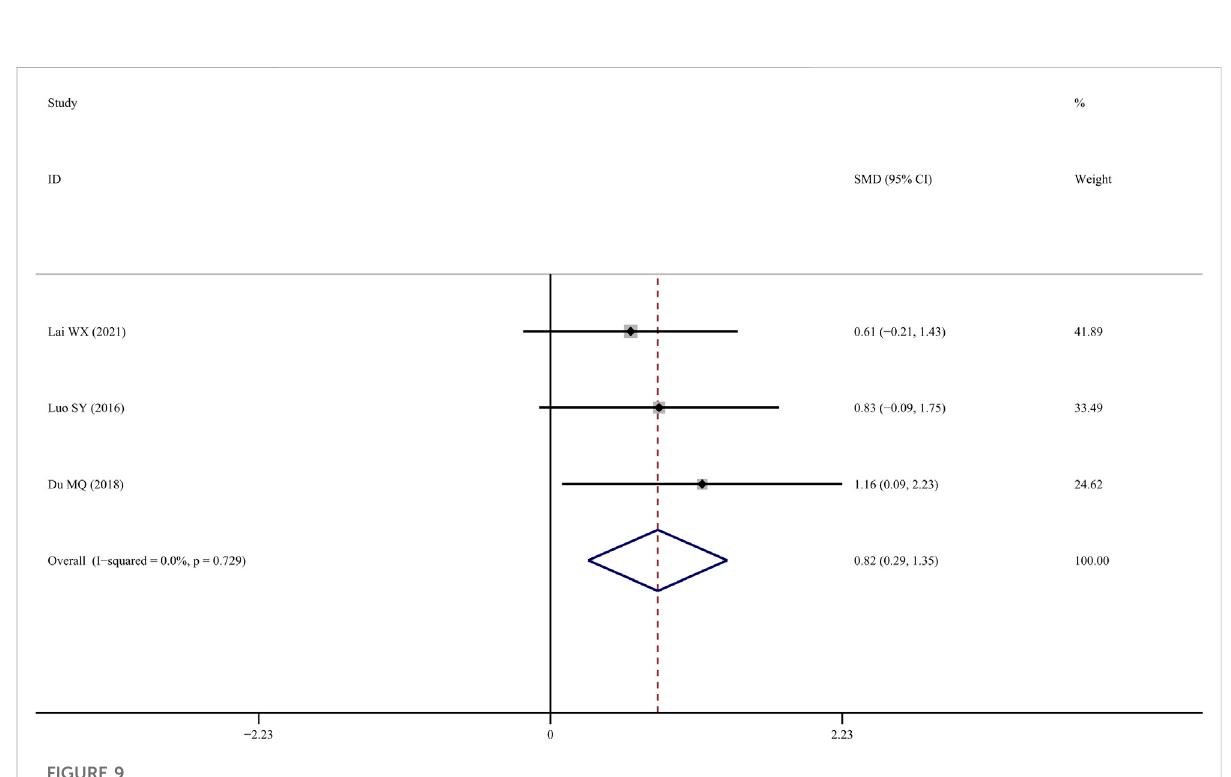
FIGURE 9 Effect of tanshinol on femur bone elastic load change in OP